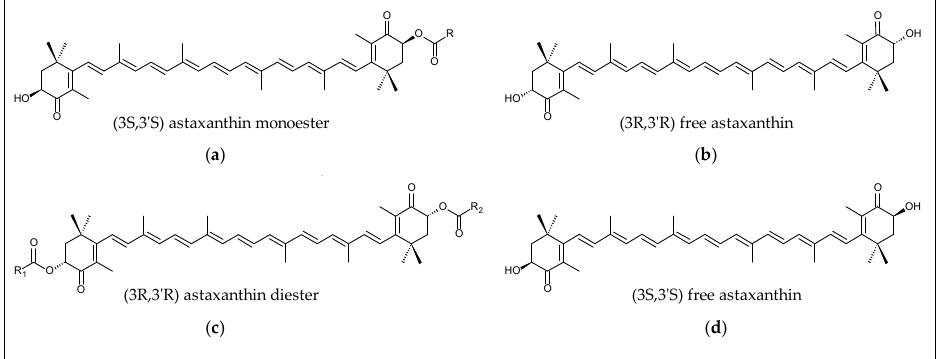
Figure 2. Predominant forms of astaxanthin in different living organisms [9,18,19,27]. ( a ) H. pluvialis ; ( b ) P. rhodozyma ; ( c ) E. superba ; ( d ) wild salmonids. R, R 1 , R 2 = carbon